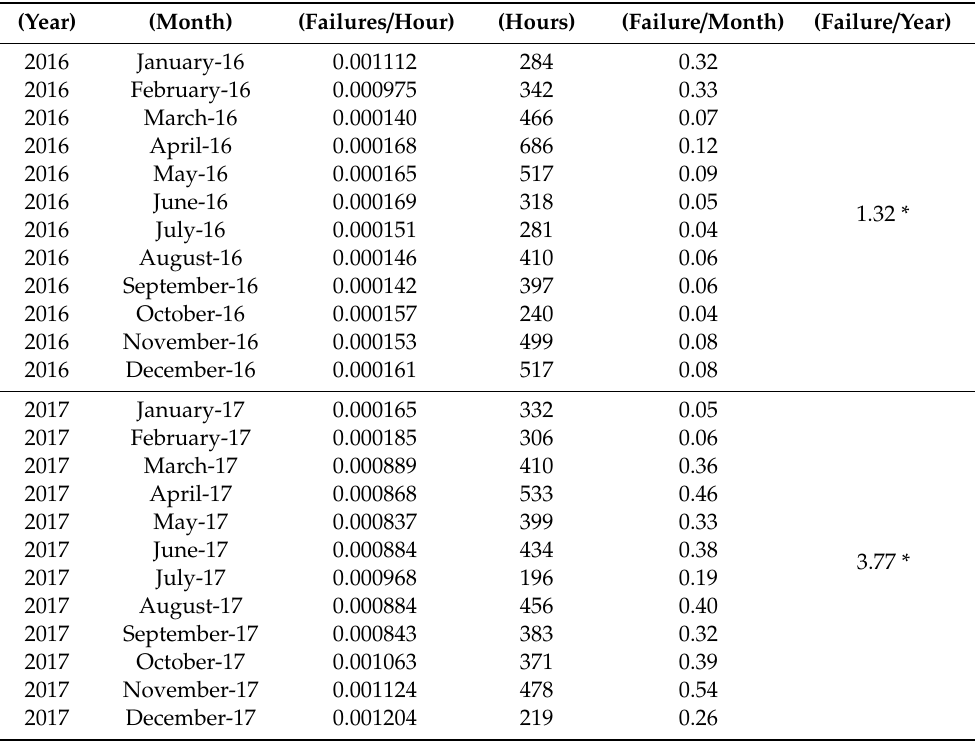
Table 11. Obtention of the annual failure rate.